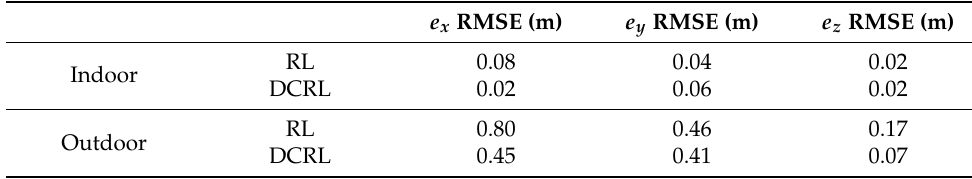
Figure 8. The estimation of external forces on x and y -axis in outdoor tracking experiment. Table 2. Root mean square errors along the three quadrotor axes in the indoor and outdoor experi-